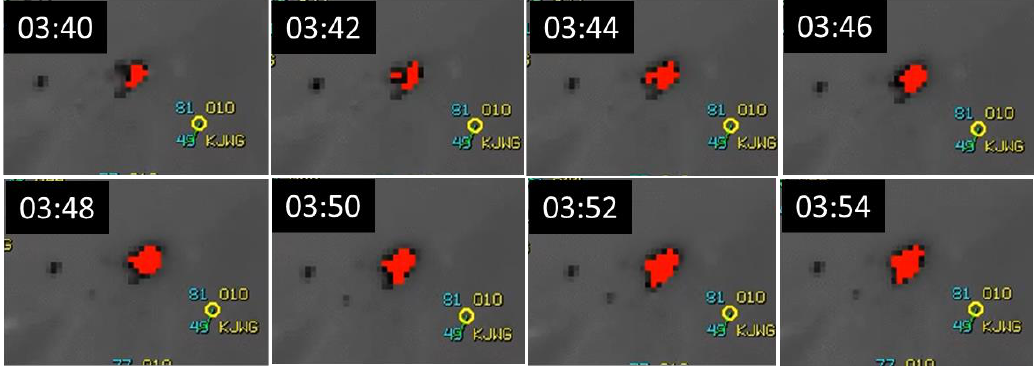
Figure 8. Sequence of satellite images from 3:40 to 3:54 UTC. Oklahoma wildfire, April 18, 2017.